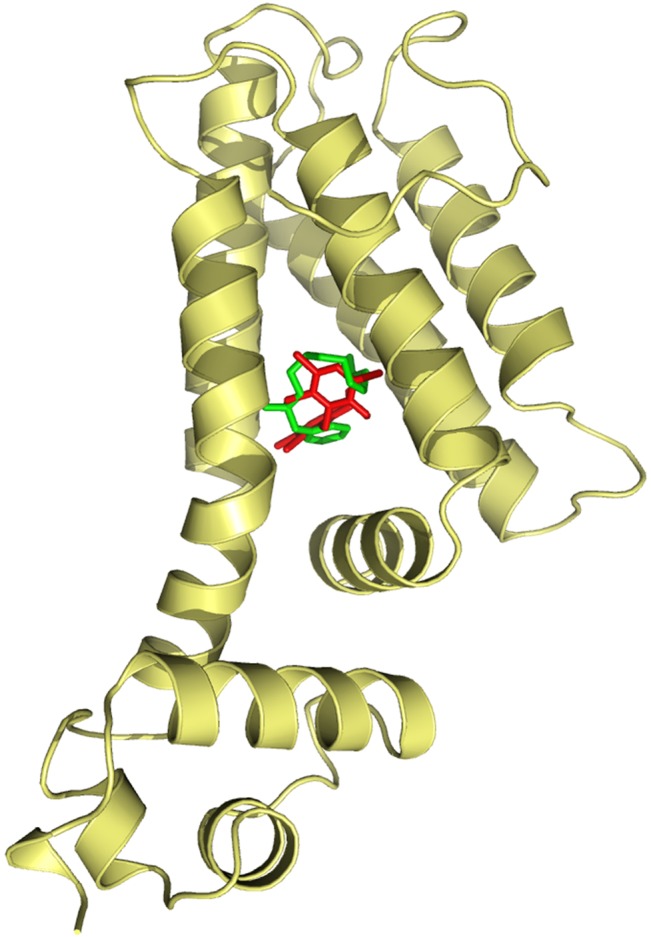
Docking of biocides to SmeT.The figure shows the best binding conformation of hexachlorophene (red) and benzalkonium (green) to the pocket of the protein. For both biocides the complex effector-protein was stabilized by hydrogen bonds and principally by hydrophobic interactions.